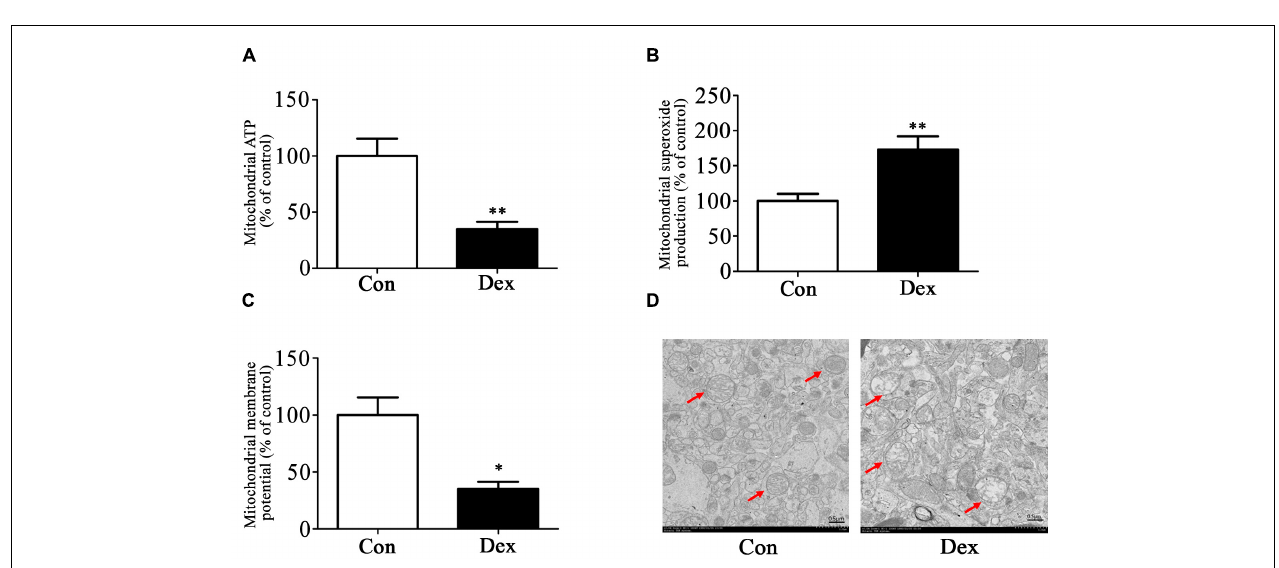
FIGURE 3 | Effects of prenatal Dex exposure on mitochondrial function and morphology in hippocampus of adult offspring. Pregnant rats at GD 14 to 21 were subcutaneously administered either 0.1 mg/kg/d Dex or vehicle (0.9% saline) once a day for 7 days. Mitochondria were isolated from the hippocampus of adult offspring rats (9-week old) for determination of ATP production (A) , mitochondrial superoxide production (B) , and membrane potential (C) as described in Section “Materials and Methods”. Mitochondrial morphology (D) was determined by transmission electron microscopy. Data are presented as means ± SEM ( n = 10/group). ∗ P < 0.05, ∗∗ P < 0.01 vs. control. Con, control; Dex,